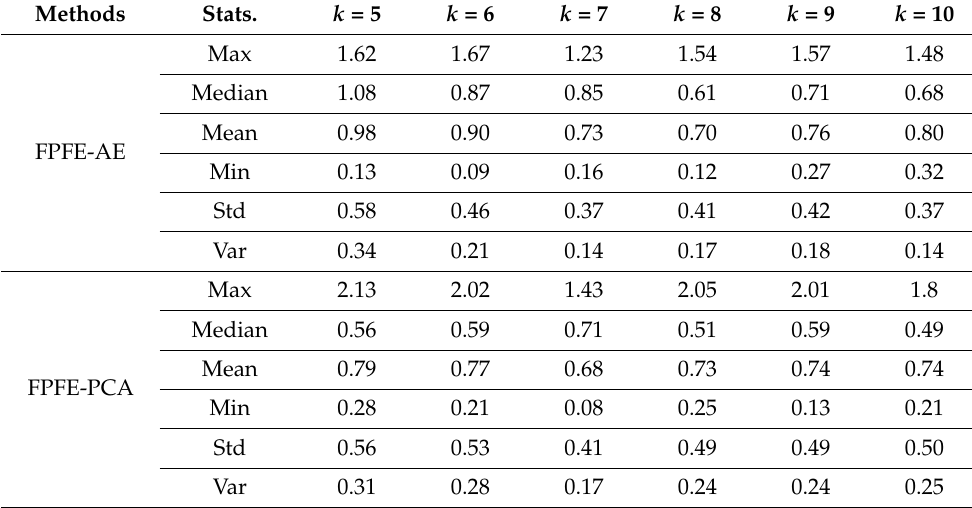
Table 1. FPFE localization error